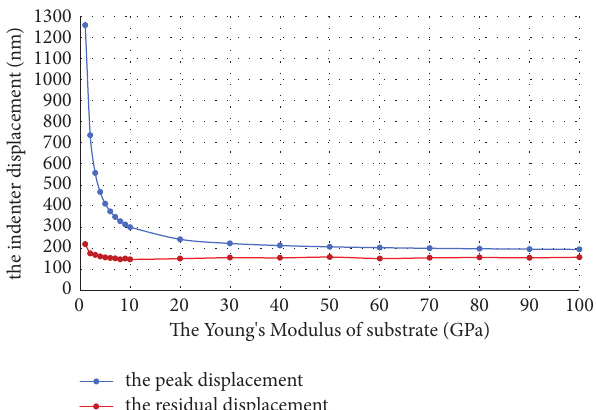
Figure 5: The relationship between displacement and E